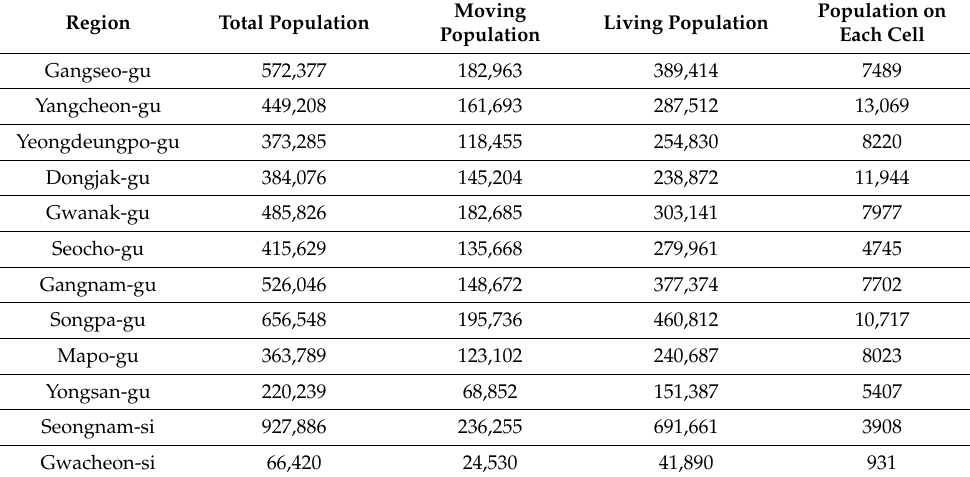
Table 9. Residents in each hexagon of metro